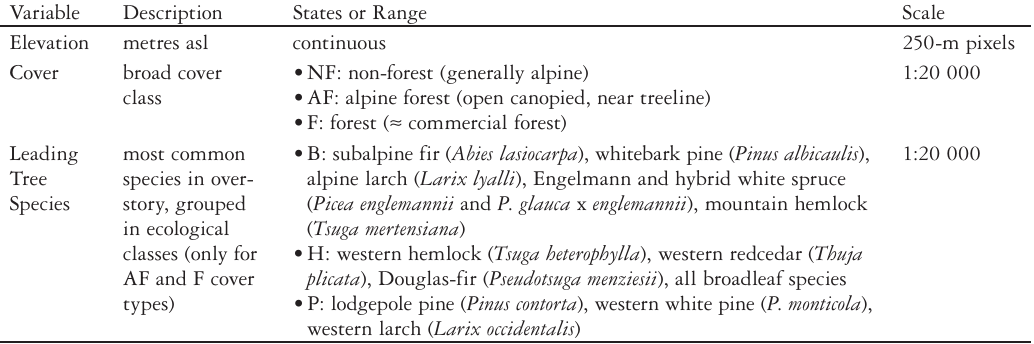
Table 1. Habitat variables derived for each caribou